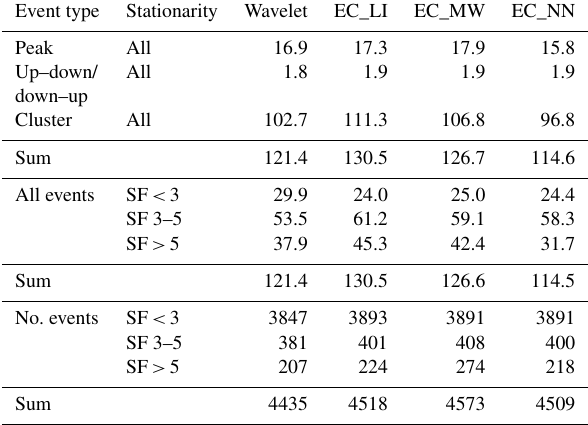
Table 5. Methane fluxes summed up for the wavelet and EC meth- ods (mgCm − 2 ) for tower 2. For EC fluxes, gaps resulting from sorting out low-stationarity cases were filled using three different gap-filling approaches (LI: linear interpolation; MW: moving win- dow; NN: neural network). Please note that gaps in the wavelet method were projected to the EC-flux time series to ensure a ho- mogeneous database for this method